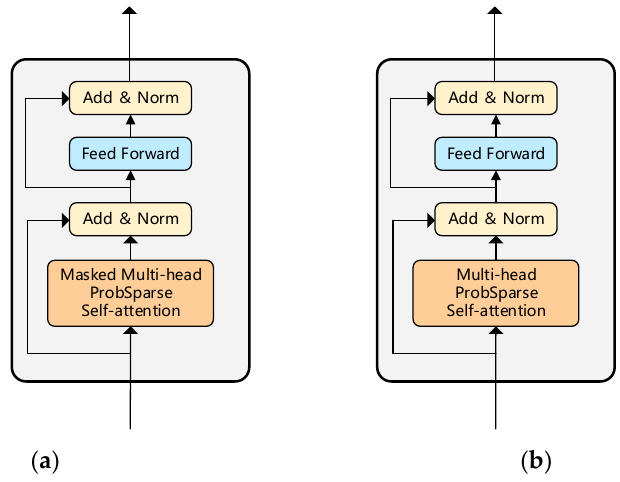
Figure 3. ( a ) Time Encoder; ( b ) Behavior Encoder.